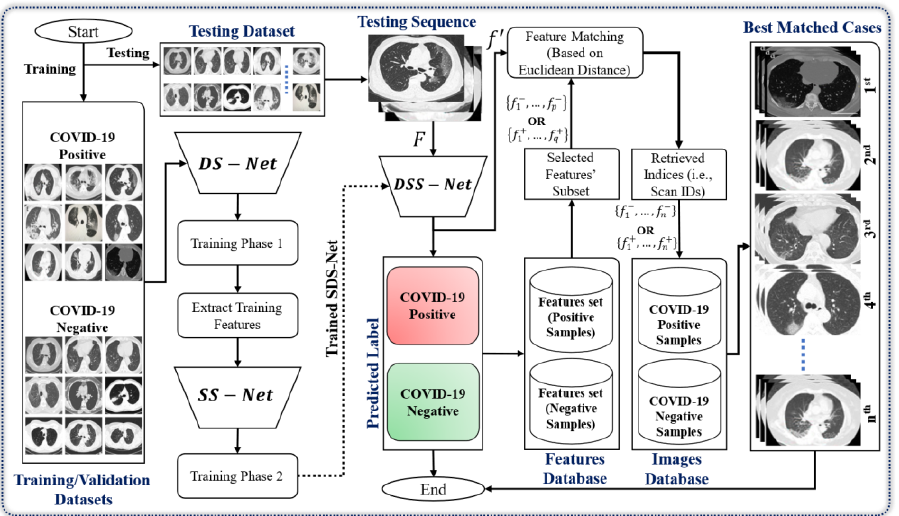
Figure 1. Schematic workflow of the proposed diagnostic framework contains the following three parts: (a) data preprocessing, (b) model development and validation using training and testing data, and (c) finally retrieving the best-matched cases from the previous record.